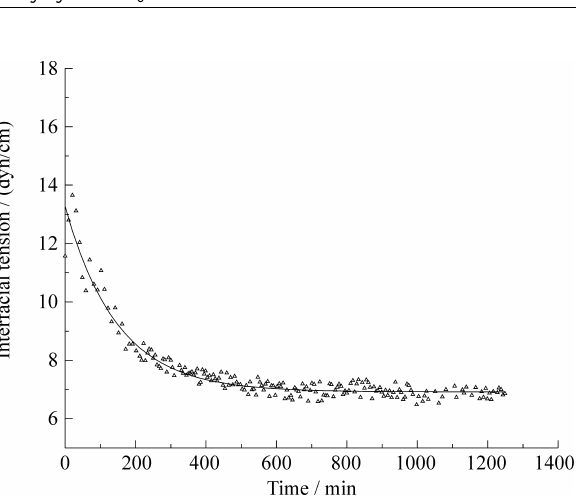
Figure 6. g (t) between polystyrene (Mn = 200,000 g/mol) and low density polyethylene at 202